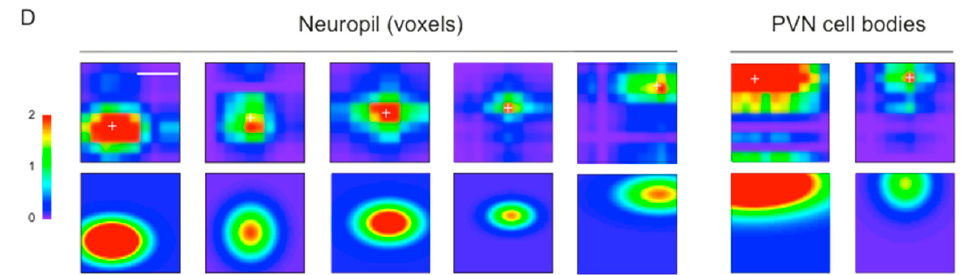
Figure 3. Mapping receptive fields in the optic tectum with small spots. ( A ) Schematic diagram of the experimental setup for visual stimulation, also illustrating the retinotopic organisation of visual input to the optic tectum: Retinal ganglion cells located in the anterior part (magenta) of the retina, convey information about the posterior part of the visual field and project to the posterior part of the optic tectum and vice versa. Yellow box shows the region imaged in ( B ). Top—representative image of an 18 dpf larvae (scale bar: 2 mm). ( B ) Dorsal view of one tectal hemisphere of a transgenic zebrafish larvae (18 dpf) expressing GCaMP3 in both the tectal neuropil (left panel) and cell bodies of PVN neurons (right panel). Confocal time series were analysed either on a voxel-wise basis (neuropil) or on a region of interest (ROI) basis (cell bodies). Cell bodies were randomly colour-coded for better visualisation. ( C ) Representative Δ F/F traces for two voxels in the neuropil, in response to a small spot moving horizontally and vertically across a 10-by-10 grid on the screen. The stimuli were presented in a pseudo-random order; the response traces shown here were manually sorted for presentation purposes. Responses to vertical and horizontal sweeps were multiplied for each location resulting in the 2D receptive fields (RFs) shown on the right. White cross indicates RF centre as determined by parametric fitting with a bivariate Gaussian distribution. ( D ) Top: Examples of spatial RFs in the tectal neuropil and cell bodies of PVN neurons, colour-coded to show response amplitudes for each point on a 10-by-10 grid. White cross indicates RF centre as determined by parametric fitting with a bivariate Gaussian distribution. Bottom: 2D RFs fitted with a bivariate Gaussian distribution. Scale bars: 50 µm (fluorescence images), 20 degrees (RFs).